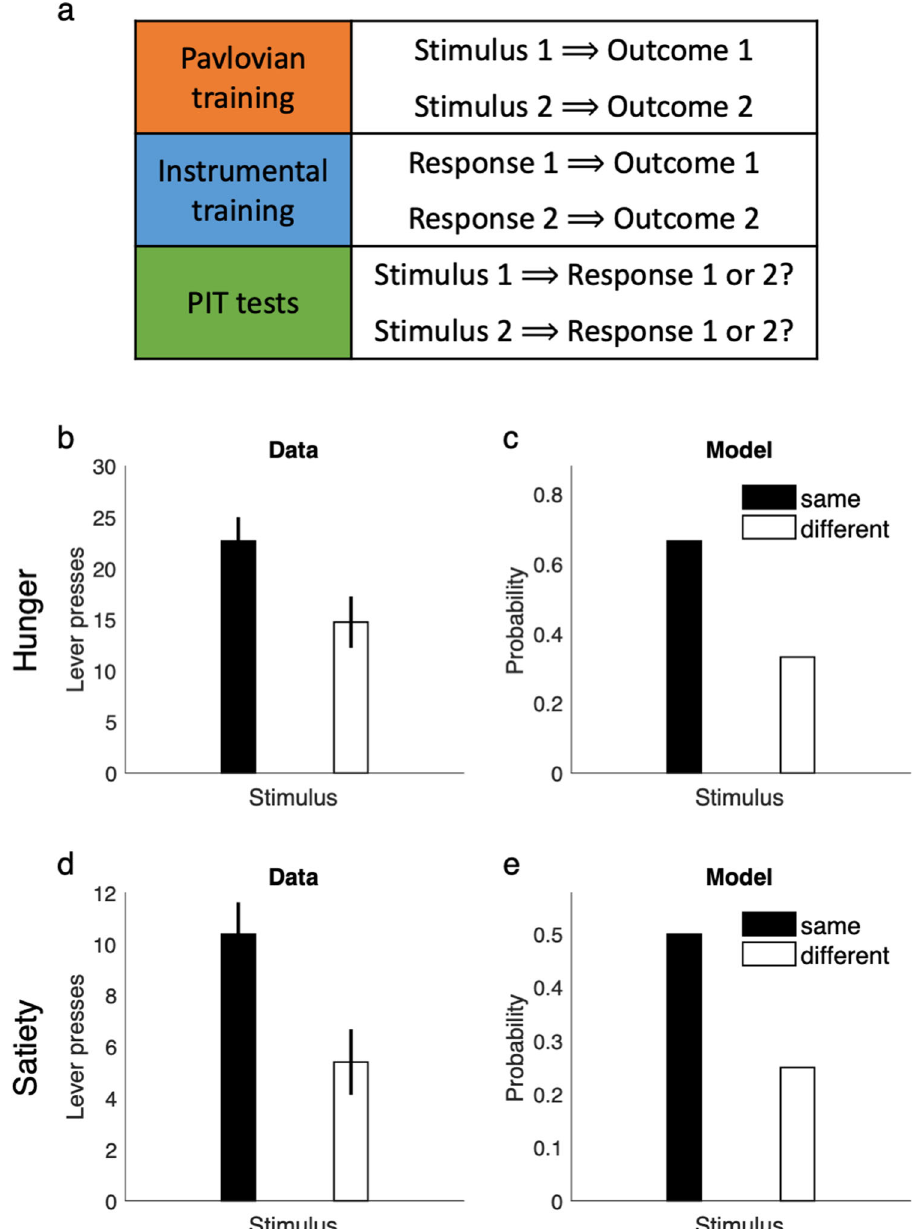
Fig. 9 Linear RL explains Pavlovian-instrumental transfer. a the task testing outcome-speci fi c PIT consists of three phases: a Pavlovian training phase, an instrumental training phase, and the PIT test. Outcomes 1 and 2 are both rewarding. During PIT test, both stimuli are presented in succession, and “ same ” responses denote the one whose associated outcome matches that associated with the presented stimulus, e.g. Response 1 chosen following presentation of Stimulus 1. The other response is “ different. ” b , c Data adapted from Corbit et al. 84 when rats are hungry ( b ) and simulated behavior of the model ( c ). The model learns the default policy during the Pavlovian phase, which biases performance during the PIT test. d , e Outcome-speci fi c PIT persists even when rats are sated on both outcomes ( d ). The model shows the same behavior ( e ) because default state probabilities learned during Pavlovian training in fl uence responses even in the absence of reward. Mean and standard error of the mean are plotted in b and d . Data in b and d are adapted from Corbit et al. 84 , in which the mean and standard error of the mean are plotted (obtained over n = 16 independent samples). Source data are provided as a Source Data fi